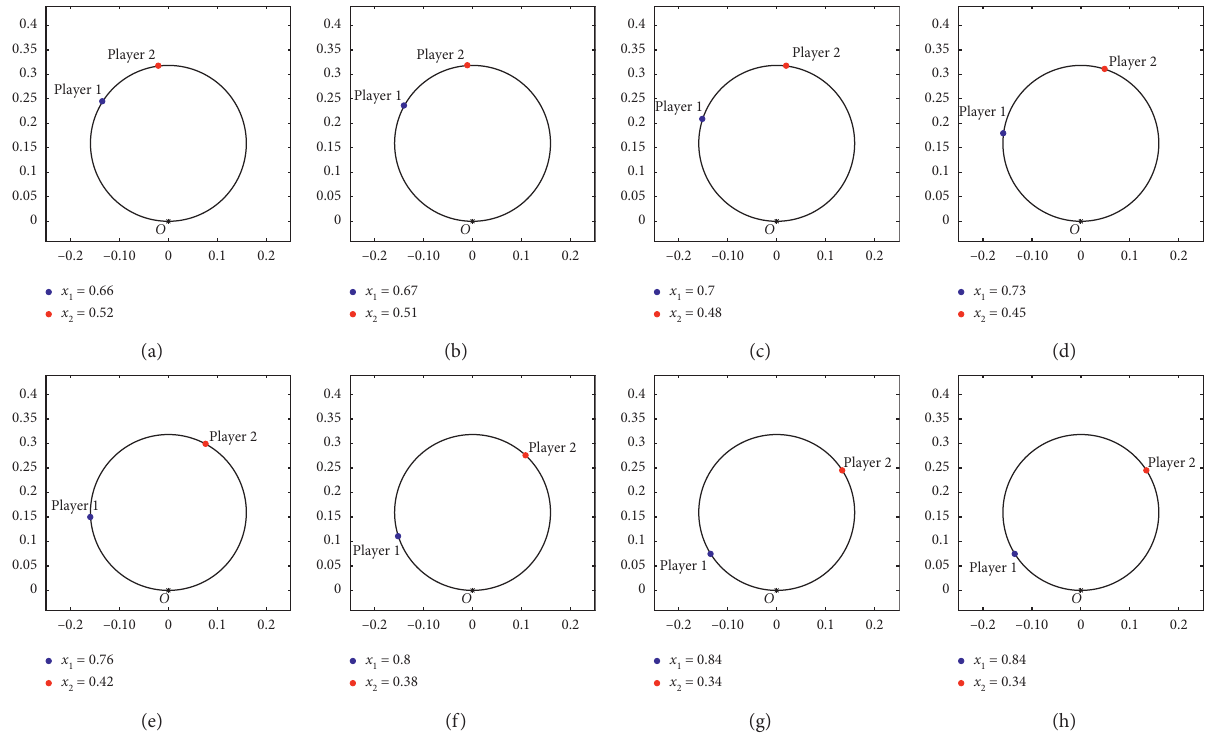
Figure 6: Dynamic evolution of the two-player location game in the closed-loop market with initial positions x